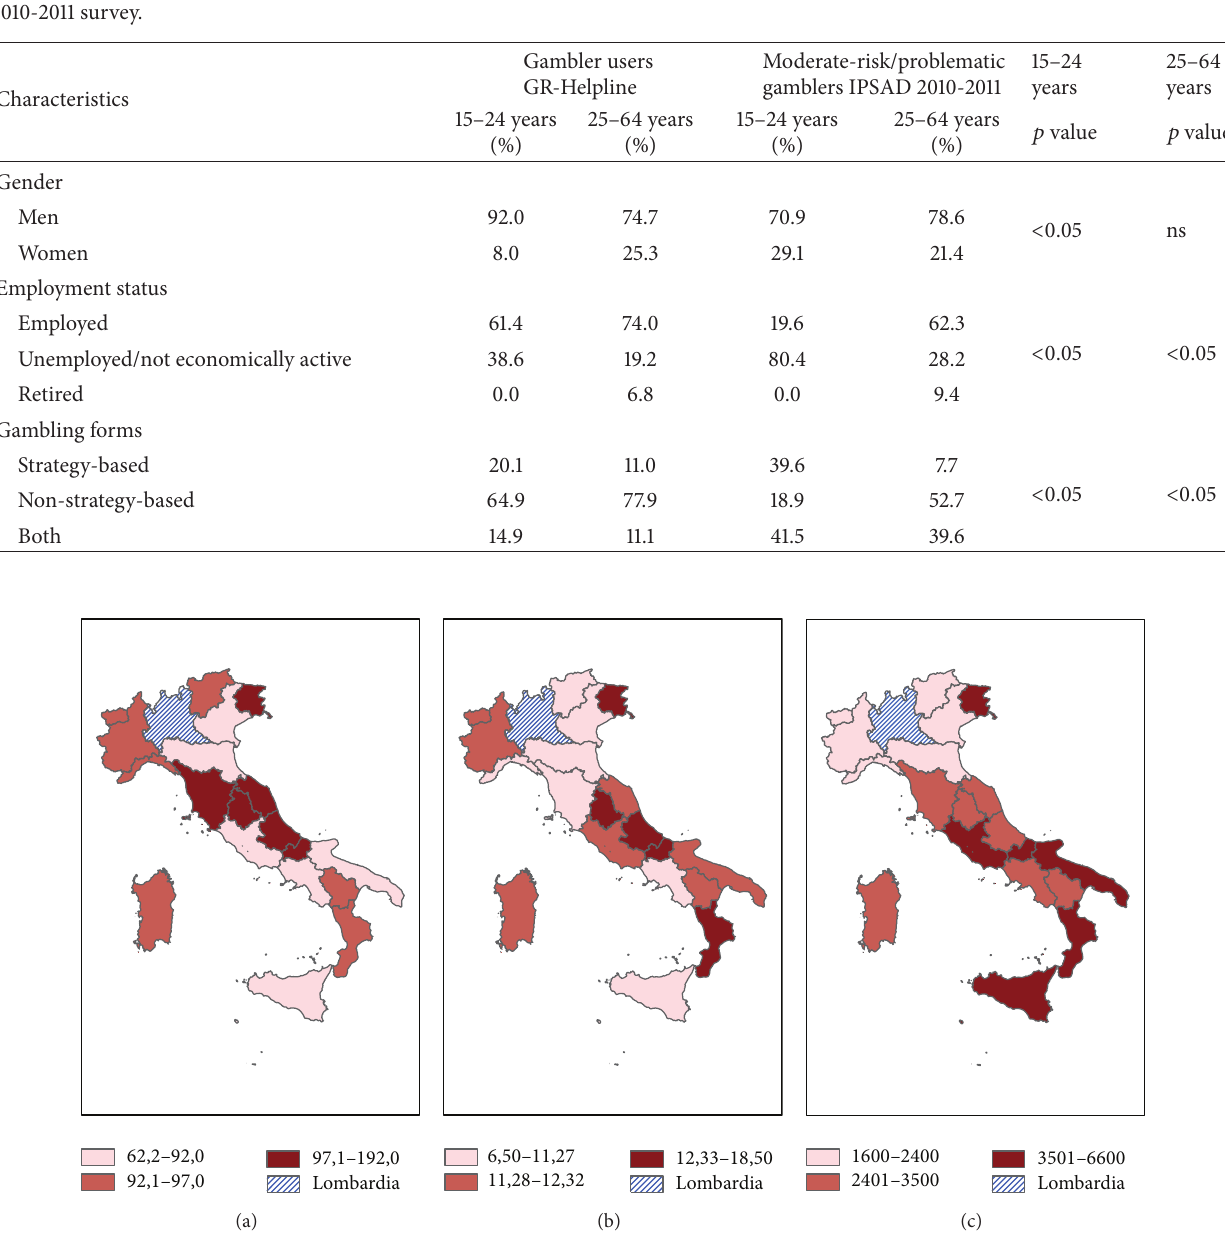
Figure 1: Regional distribution of informative materials of GR-Helpline (a); regional distribution of gamblers and families/friends using GR-Helpline (b); regional distribution of moderate-risk/problematic gamblers of IPSAD 2010-2011 survey (c), expressed as rate 1/100.000 inhabitants aged 15–64